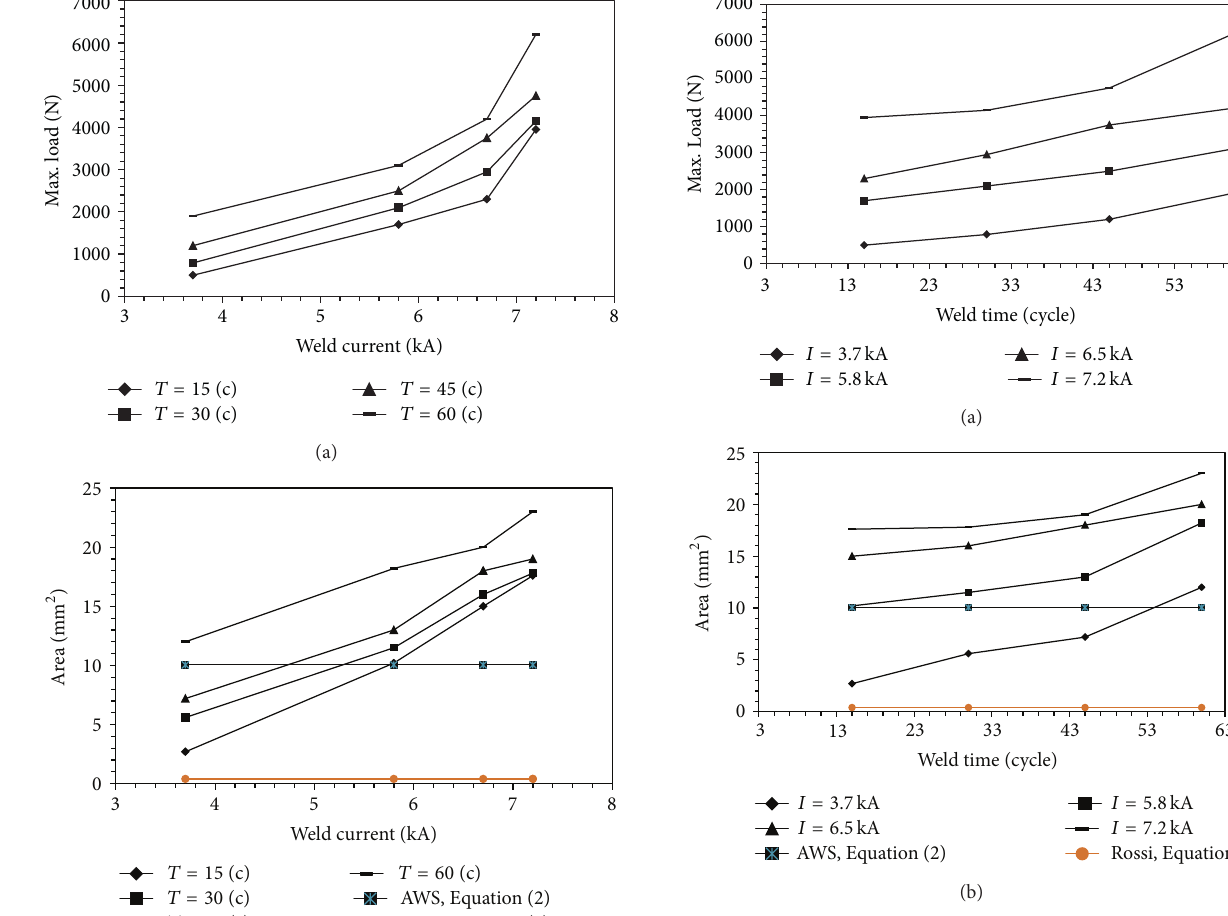
Figure 5: Effect of time of the peel joints; 𝑑 (a) tensile strength; (b) weld nugget = 4mm, 𝑡 = 0.8 mm; el